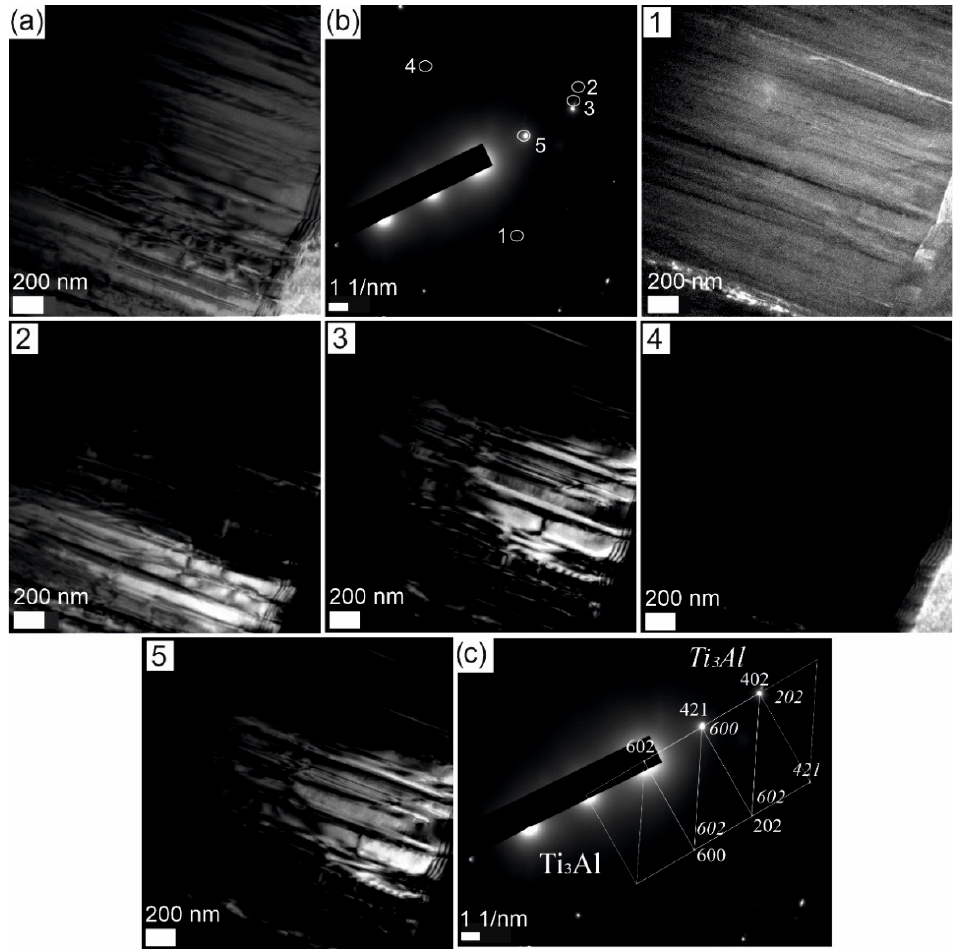
Figure 4. BF images of the Ti-Al-Y alloy ( a ) SAED pattern ( b ) of the Ti-Al-Y alloy with the bright- field image. SAED patterns of the Ti-Al-Y alloy in the relevant region ( c ). The dark-field image of Ti-Al-Y (1). The dark-field images (1)–(5) correspond to reflexes (1)–(5) in the microdiffraction pattern ( b ).